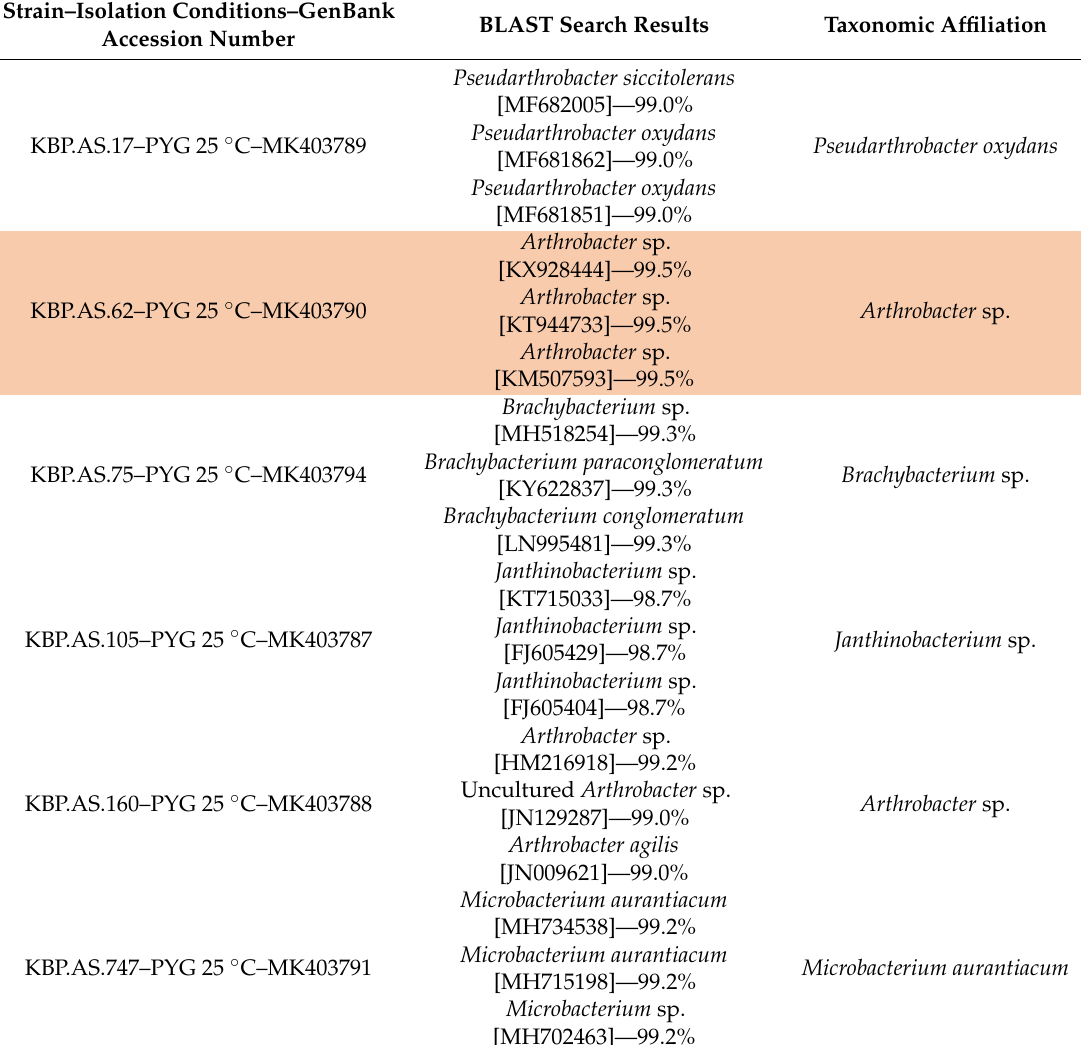
Table A1. Taxonomic affiliation of isolated